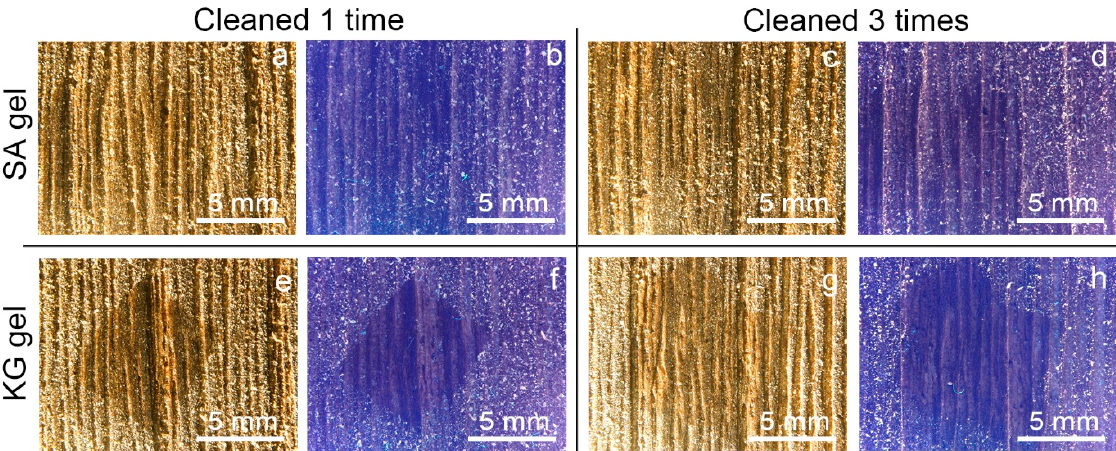
Figure 4. Stereomicroscopy images in visible and UV light of soiled-WM cleaned at different appli- cation times with SA and KG gels: ( a , b ) SA_1, ( c , d ) SA_3, ( e , f ) KG_1, and ( g , h ) KG_3.